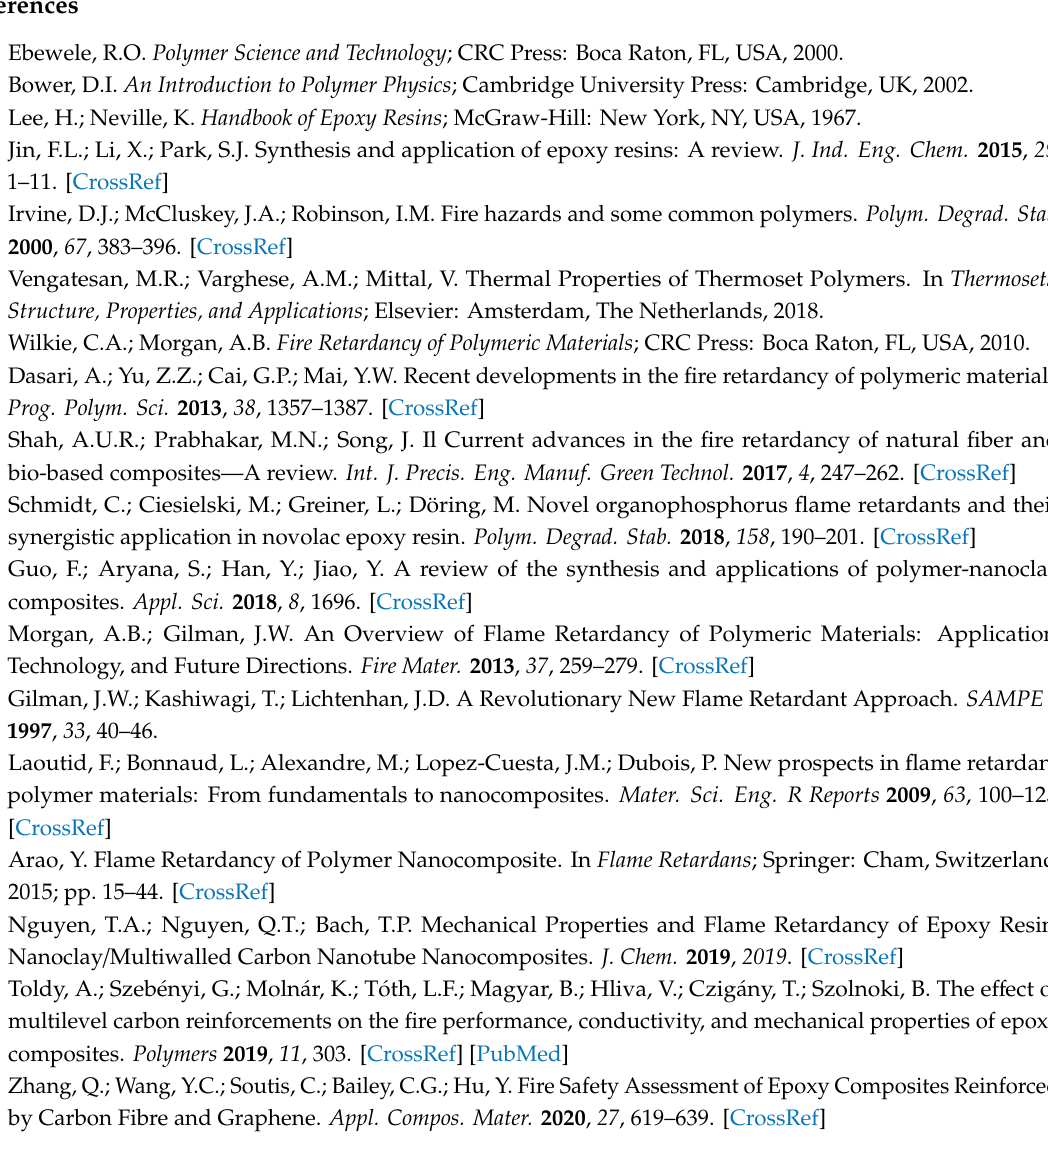
Figure S1: C1s XPS spectrum of EG sample. Figure S2: DSC curve of the oxidation of EG sample (air, 10 K / min, Al 2 O 3 ). Figure S3: Results on ASTM E698 analysis of E0 sample. Figure S4: Results on ASTM E698 analysis of E / 0.5MWCNT sample. Figure S5: Results on ASTM E698 analysis of E / 0.5EG